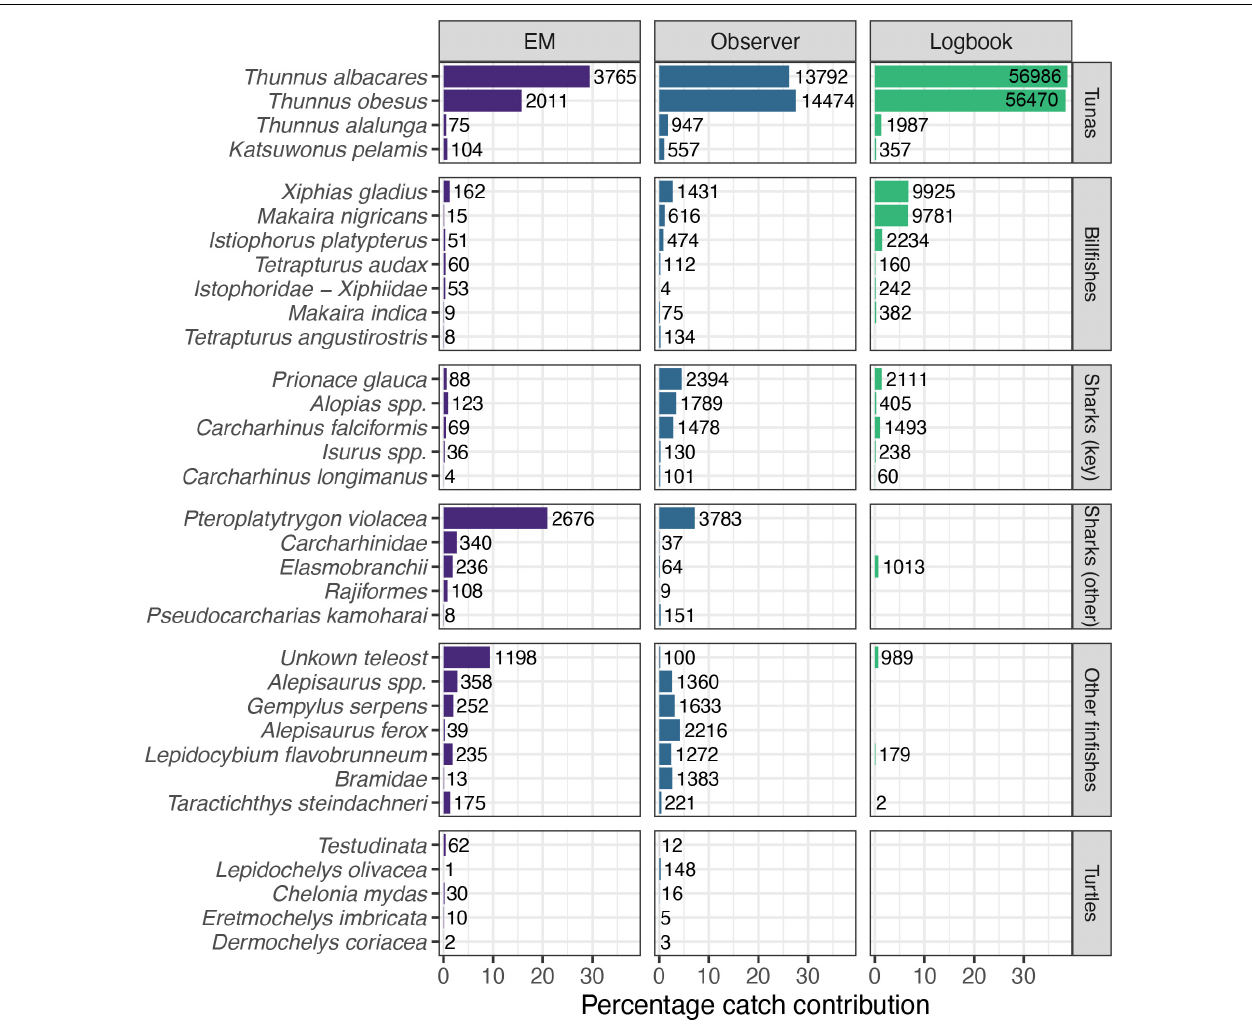
FIGURE 3 | Percentage contribution of target and bycatch species observations to total catch (number of individuals) as recorded in each data source [Electronic Monitoring (EM), Observer and Logbook]. Number labels next to each record show the total number of observations recorded from 2016 to 2018 (EM) and 2010–2019 (Observer and Logbook). Figure shows a subset of selected species (see Methods for selection criteria; note varying resolution of taxa). Key sharks as identified by the Western and Central Pacific Fisheries Commission